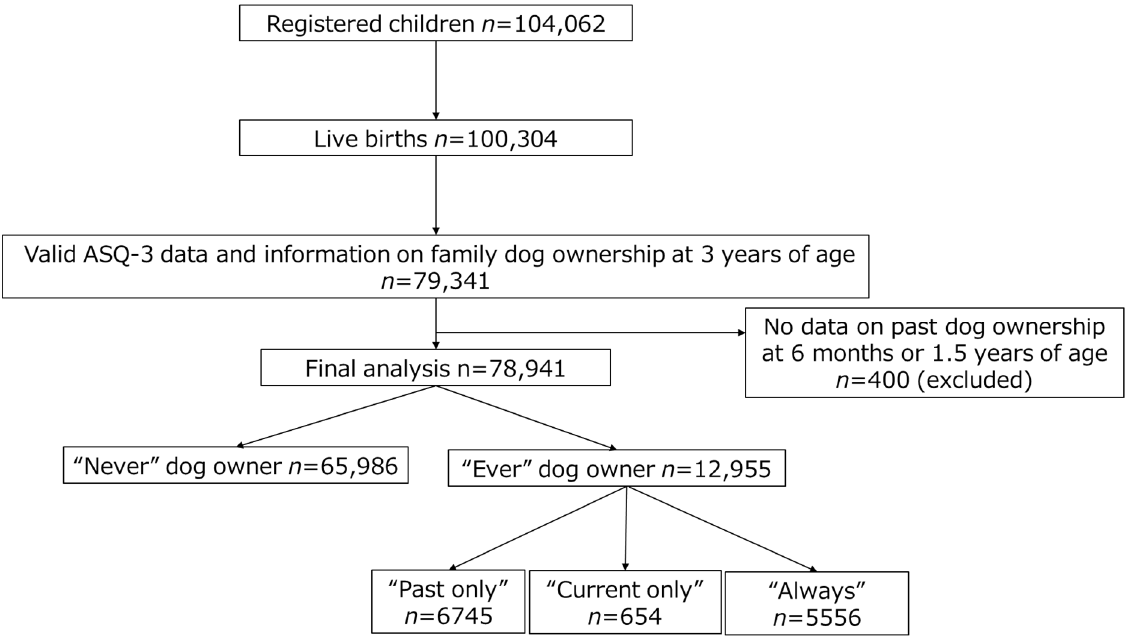
Figure 1. Selection of the study population.